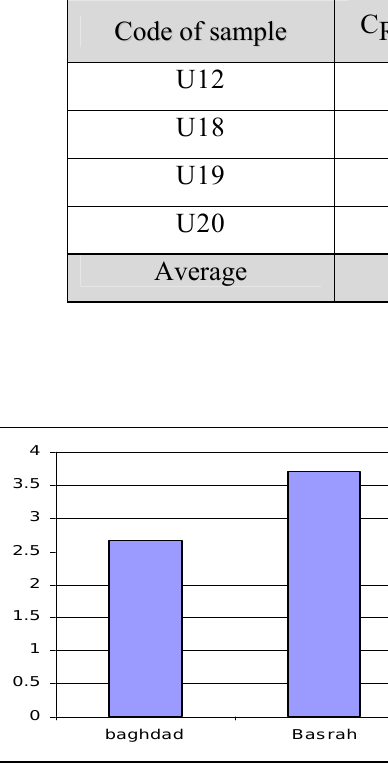
Fig.7: The average of radon concentrations in urine human for Baghdad, Basrah and Ramadi